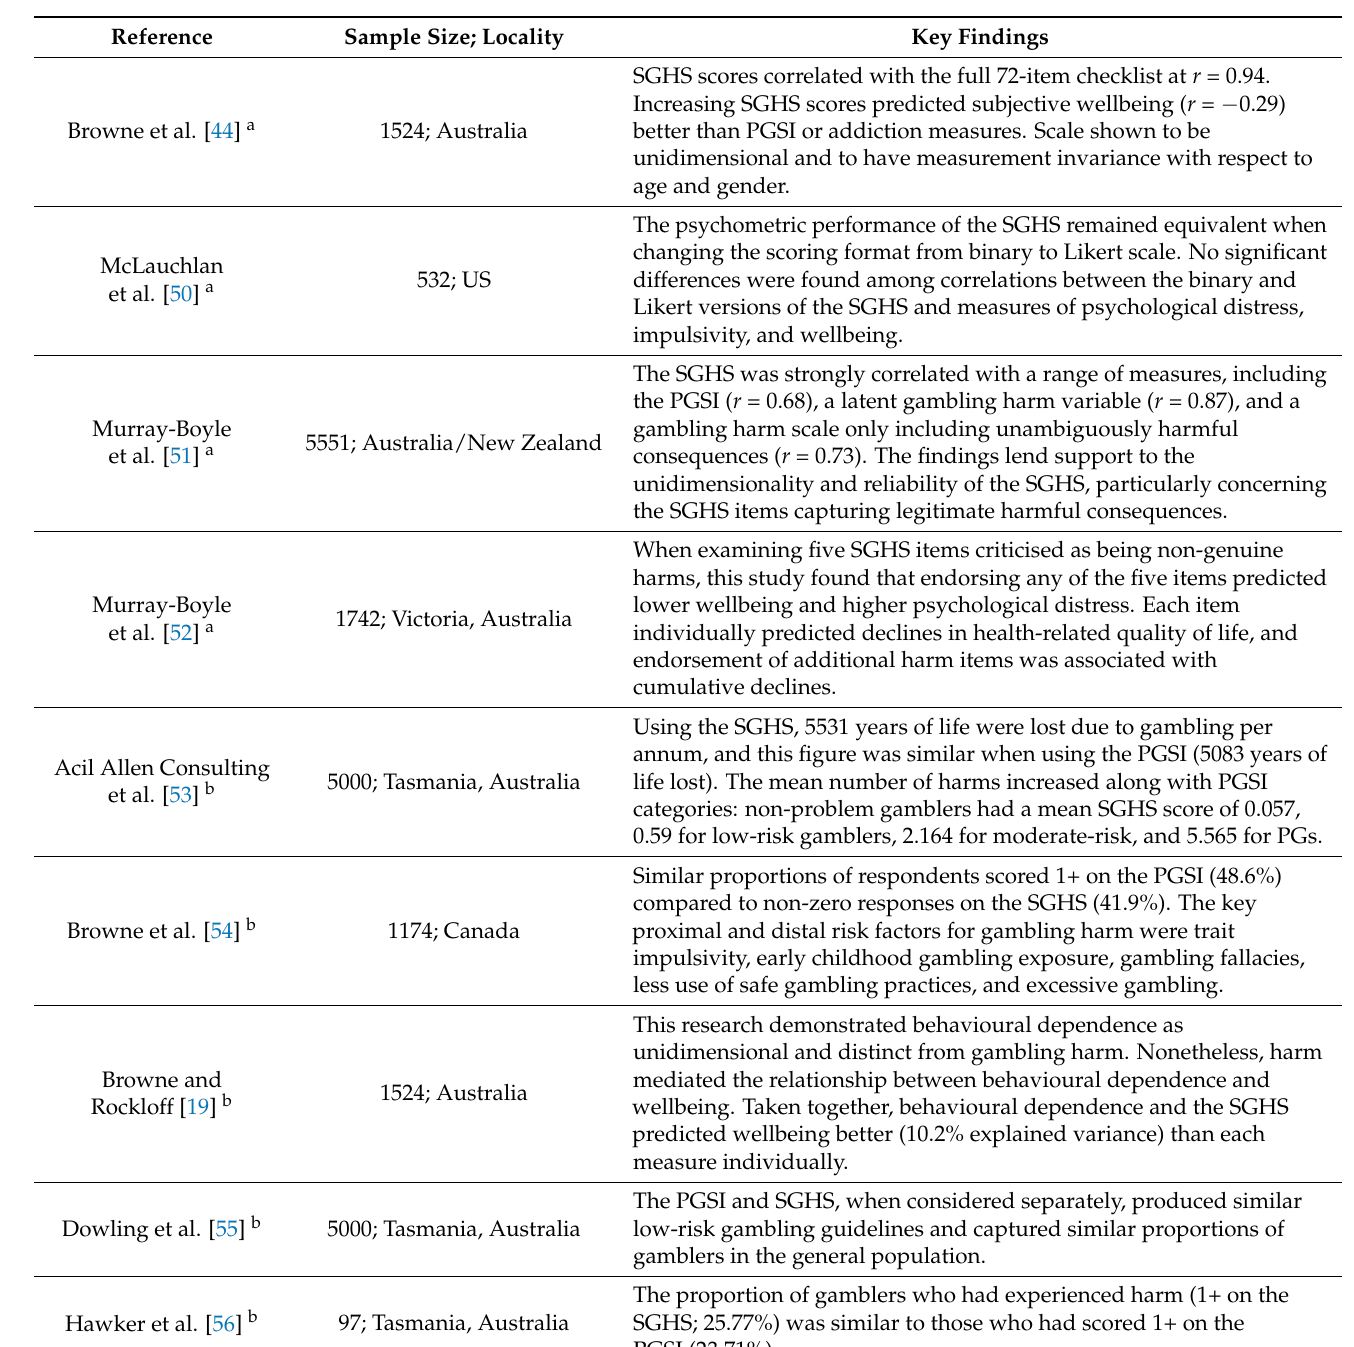
Table 1. Overview of studies employing the